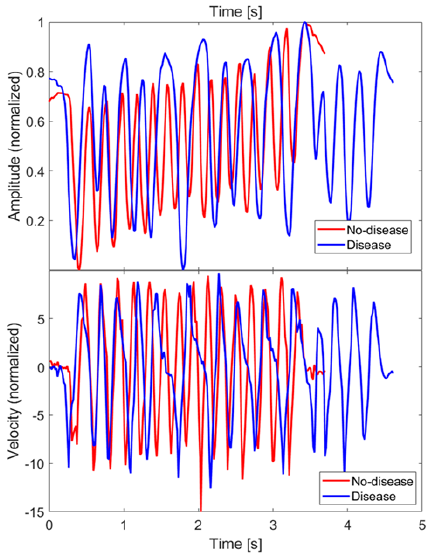
Figure 9. Amplitude ( z sc ) and velocity of the FT of the index fingertip measured along z direction, for both the no-disease and disease cases. Velocity has been calculated by finite differences.